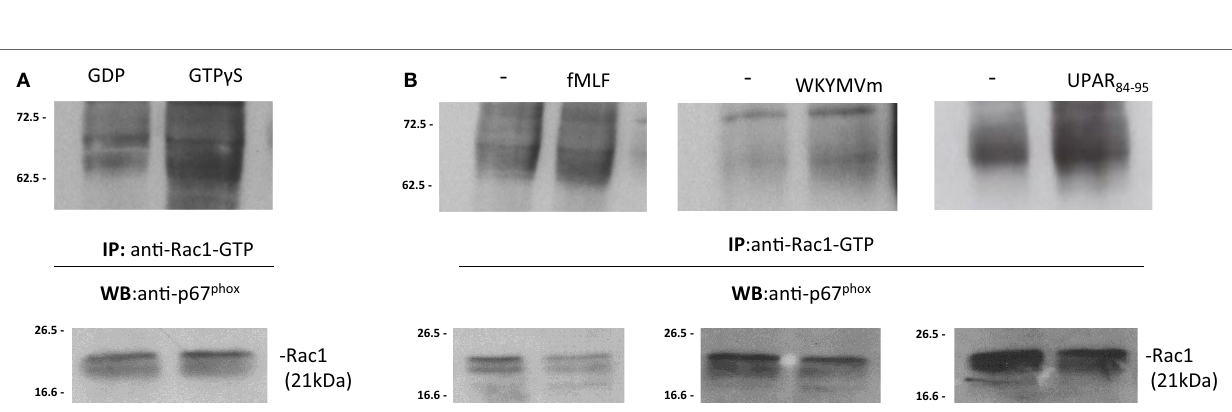
FigUre 6 | FPRs-mediated Rac1 GTP-p67 phox interaction in BJ cells. (a) BJ cells lysates were treated with GDP and GTP γ S (Upstate) to generate Rac1-GDP and Rac1-GTP, respectively. Rac1-GDP and Rac1-GTP containing lysates were precipitated using the p21-binding domain (PBD) of PAK1, bound to agarose beads. Eluted samples and the corresponding total lysates were subjected to Western blot analysis with a polyclonal anti-p67 phox antibody and with anti-Rac1 antibody as a loading control, respectively. (B) BJ cells, after incubation with medium alone (-), N -formyl- l -methionyl- l -leucyl- l -phenylalanine (fMLF), WKYMVm peptide, for 5 min, or uPAR 84–95 (10 − 8 M) for 30 min at 37°C in a humidified (5% CO 2 ) incubator, were lysed and subjected to Rac1 activity assay. Active Rac1 (Rac1-GTP) was precipitated from cell lysates using the PBD of PAK1, bound to agarose beads. Eluted samples and the corresponding total lysates were subjected to Western blot analysis with a polyclonal anti-p67 phox antibody and with anti-Rac1 antibody as a loading control,